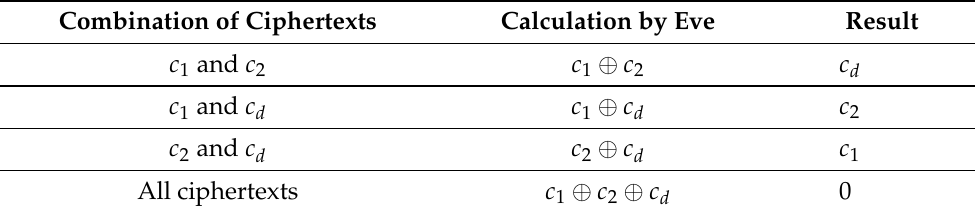
Table 1. Information that Eve can obtain by combining ciphertexts. Combination of Ciphertexts Calculation by